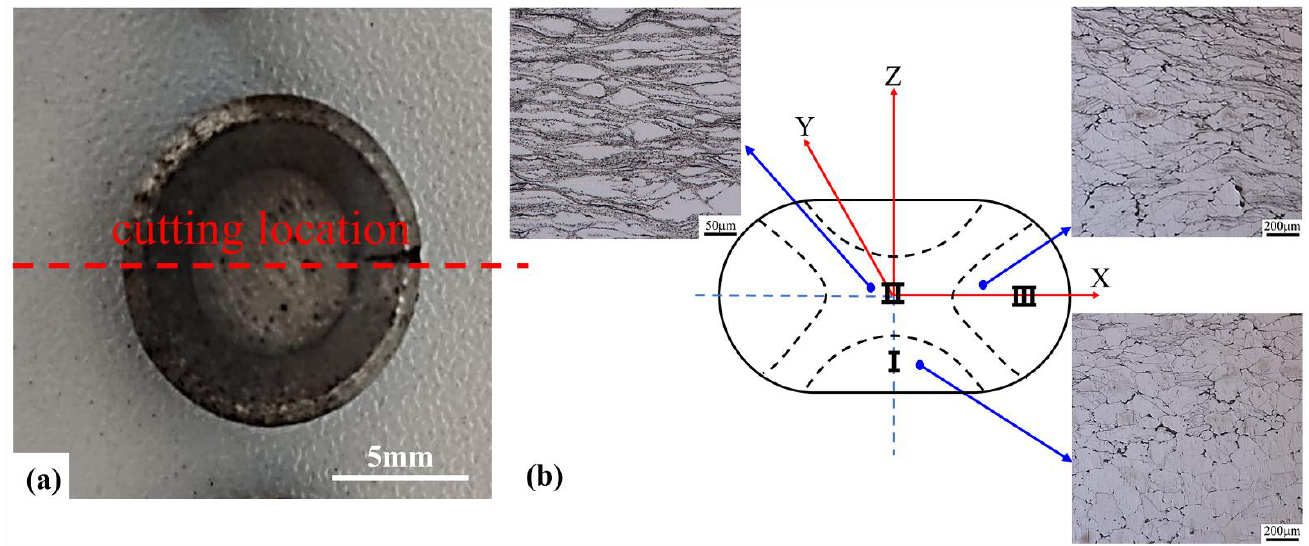
Figure 1. ( a ) Macroscopic photo of compressed sample and ( b ) the microstructures in different deformation domains.